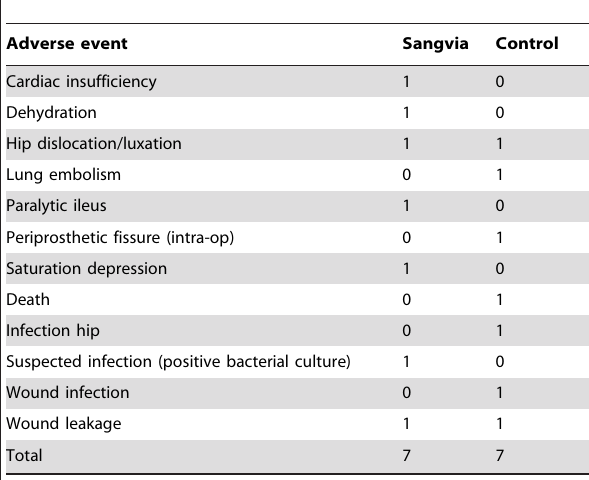
Table 5. Reported serious 1 adverse